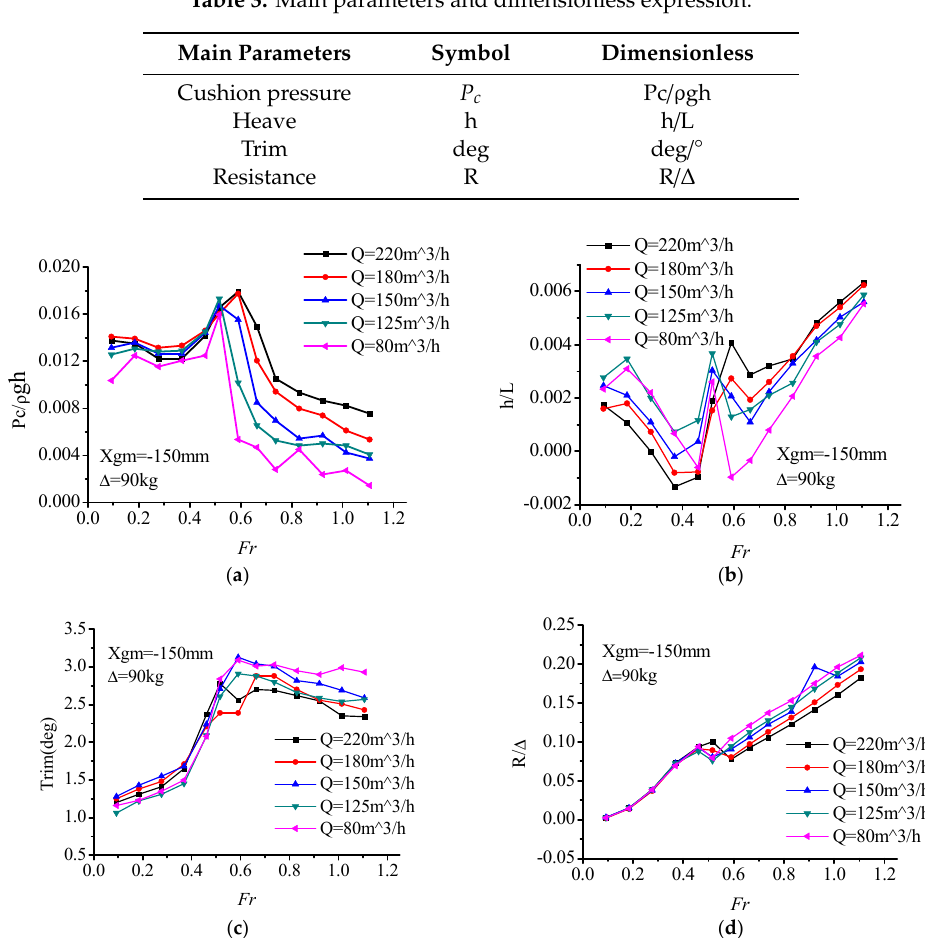
Table 3. Main parameters and dimensionless expression.